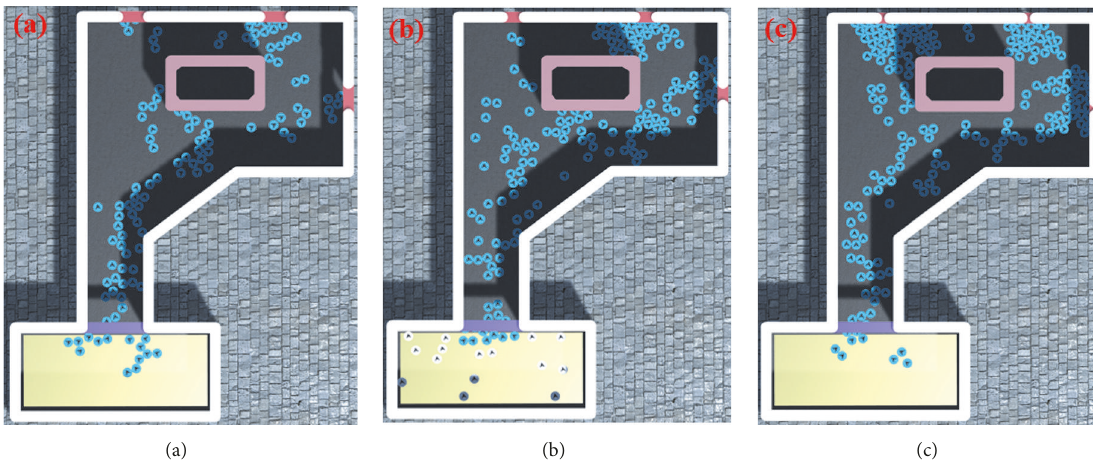
Figure 4: Still images from the simulation setups 1, 2, and 3 (Images (a), (b), and (c), respectively). The three setups share the same type of geometry except for their widths of exits. In setups 1, 2, and 3, exit widths are, respectively, 150cm, 100cm, and 50cm. Therefore, they create evacuation scenarios in the same geometric layout and under three different levels of crowding.